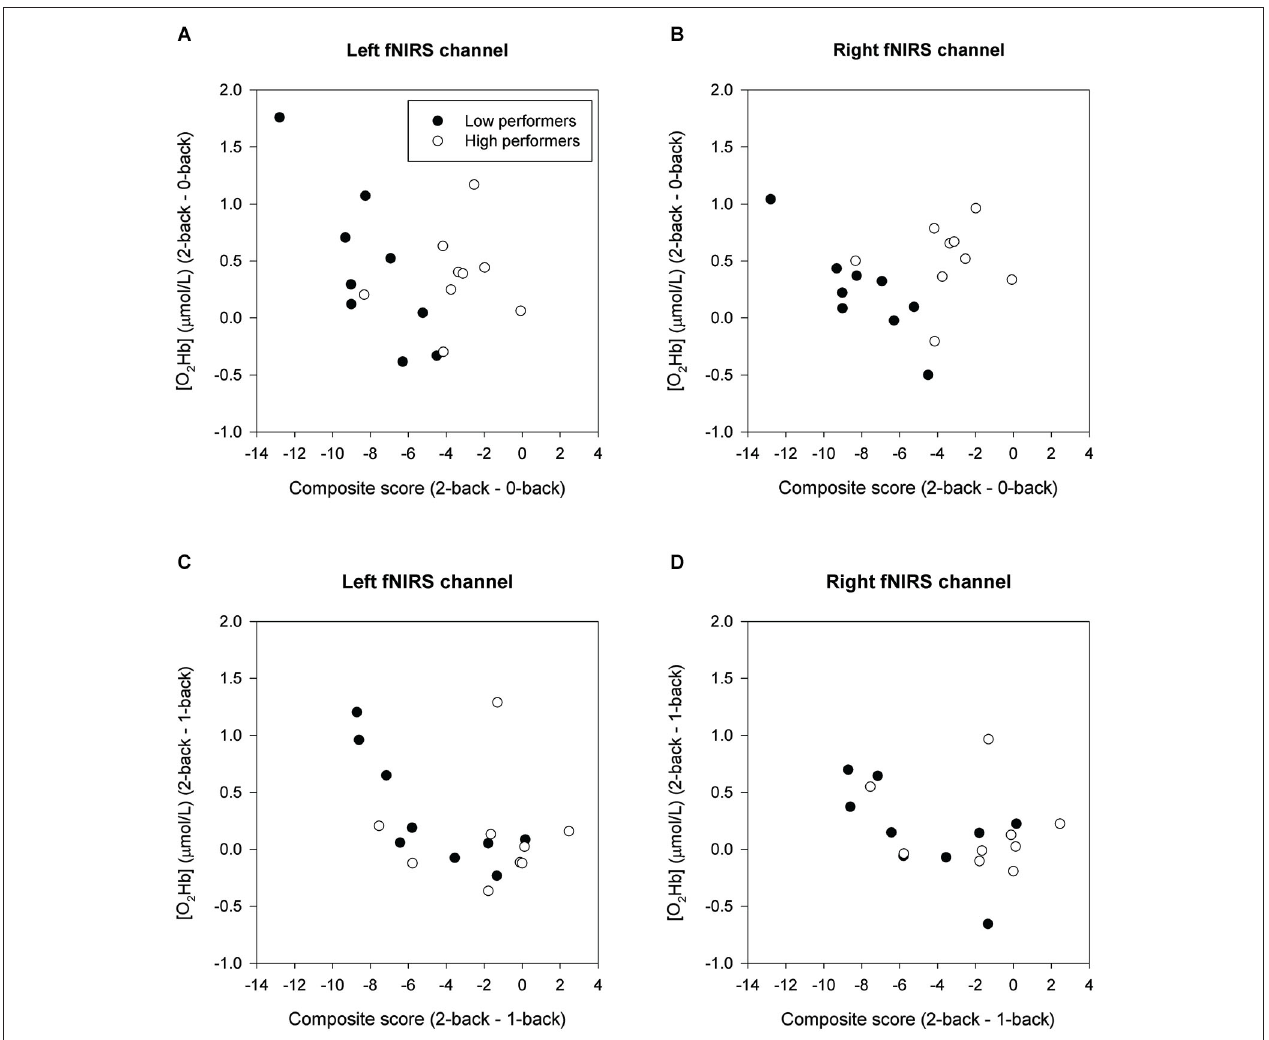
FIGURE 4 | Correlation of ∆ Composite score and ∆ [O 2 Hb] in low and high performers. (A) and (B) show the 2-back minus 0-back contrast. (C) and (D) show the 2-back minus 1-back contrast.